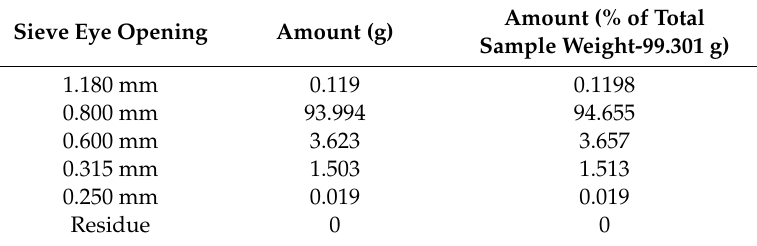
Table 8. Size distribution of the inert